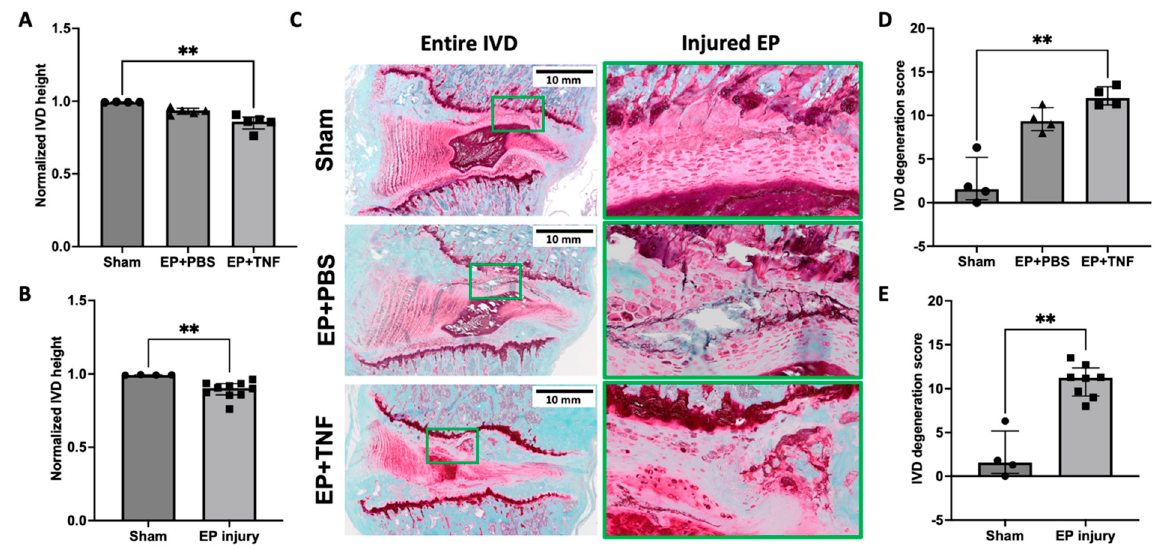
Figure 3. EP injury induced IVD height loss and IVD degeneration. ( A ) EP injury with TNF α injection decreased normalized IVD height. ( B ) Combined EP injury decreased normalized IVD height. ( C ) Representative histological images of entire IVD and highlighted injured EP region (green box) from different experimental groups. ( D ) EP injury with TNF α injection exhibited higher IVD degeneration score. ( E ) Combined EP injury showed higher IVD degeneration score. ** p < 0.01.